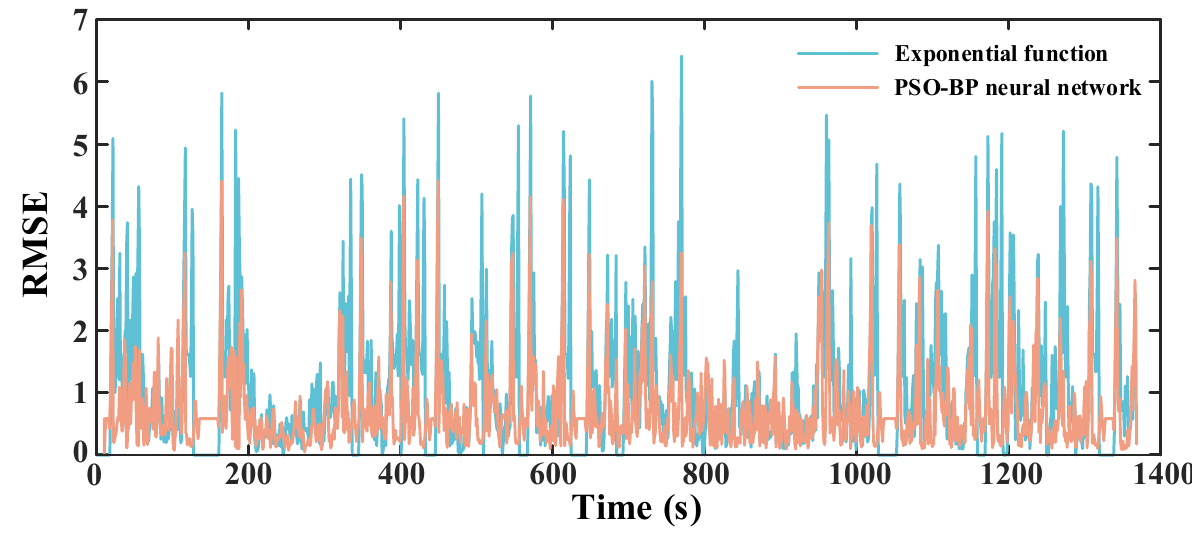
Figure 14. Root − mean − square error of exponential prediction and PSO − BP neural network predic- tion.